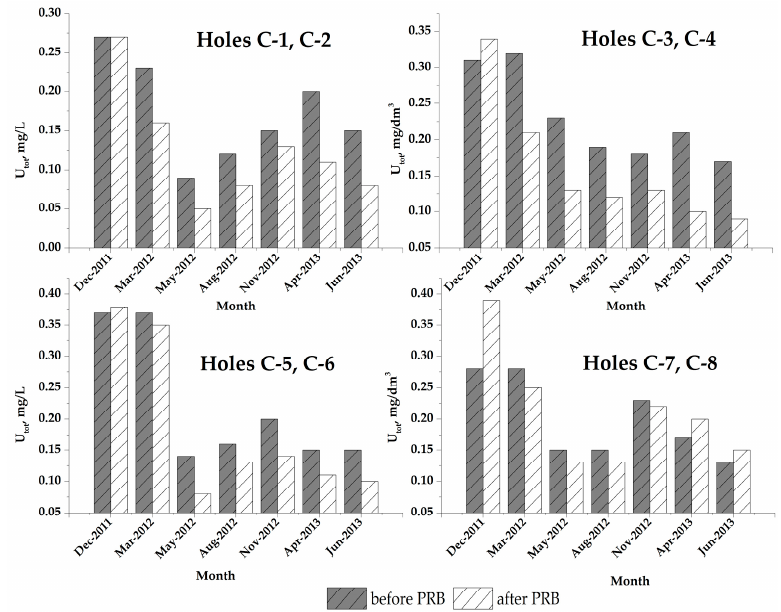
Figure 8. Uranium content in groundwater at PRB site: before PRB (monitoring hole C-1, C-3, C-5, C-7); after PRB (monitoring hole C-2, C-4, C-6, C-8) (Figure 7).